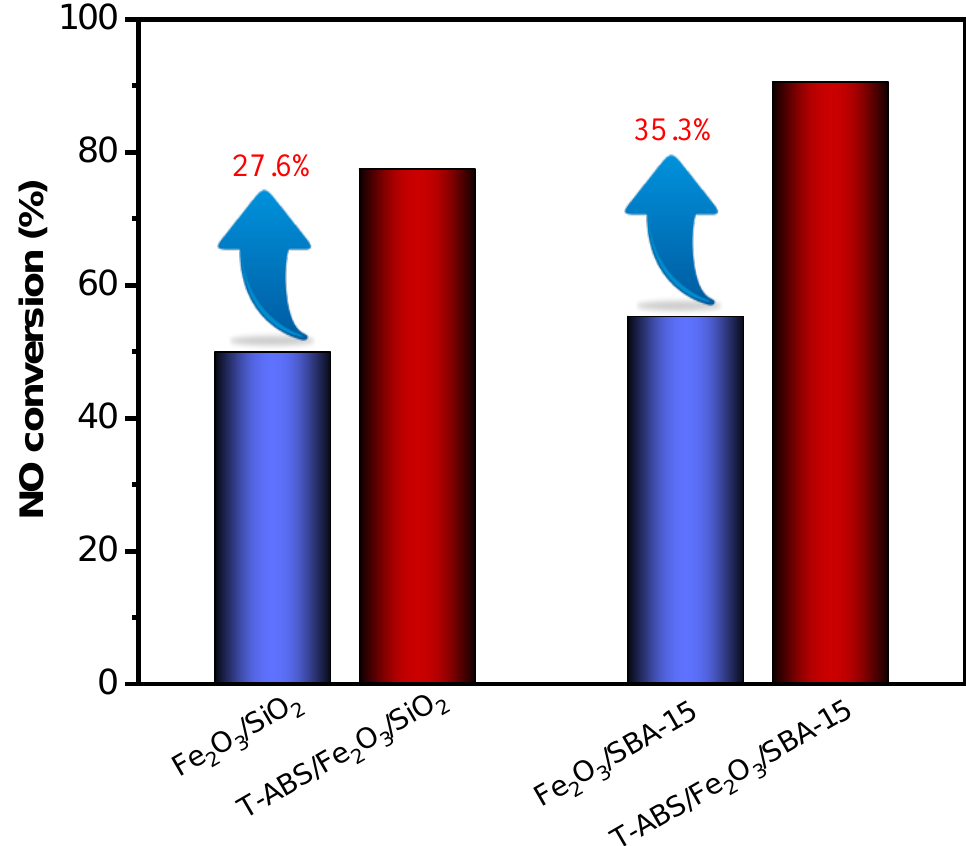
Figure 6. Effect of the SO 42 − immobilization on the catalytic performances of Fe 2 O 3 /SiO 2 and Fe 2 O 3 /SBA-15 at 350 °C. Reaction conditions: 500 ppm NO, 500 ppm NH 3 , 5% O 2 , and WSHV of 60,000 mL·g −1 ·h −1 .